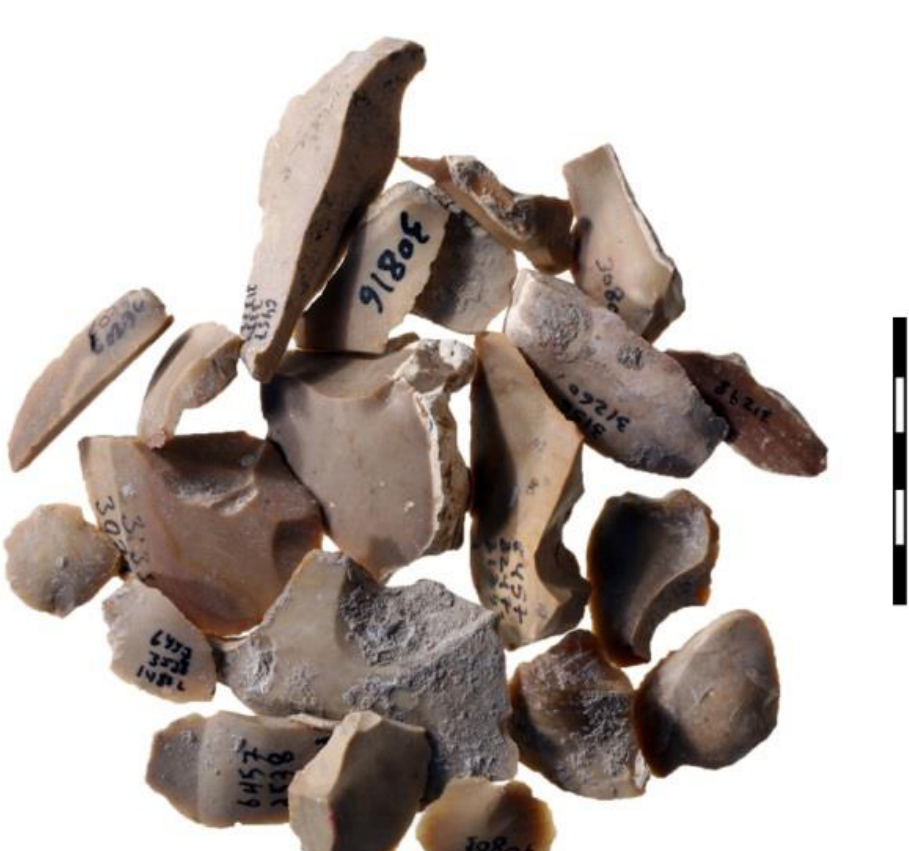
Figure 5. Group of cores-on-flakes (COFs).